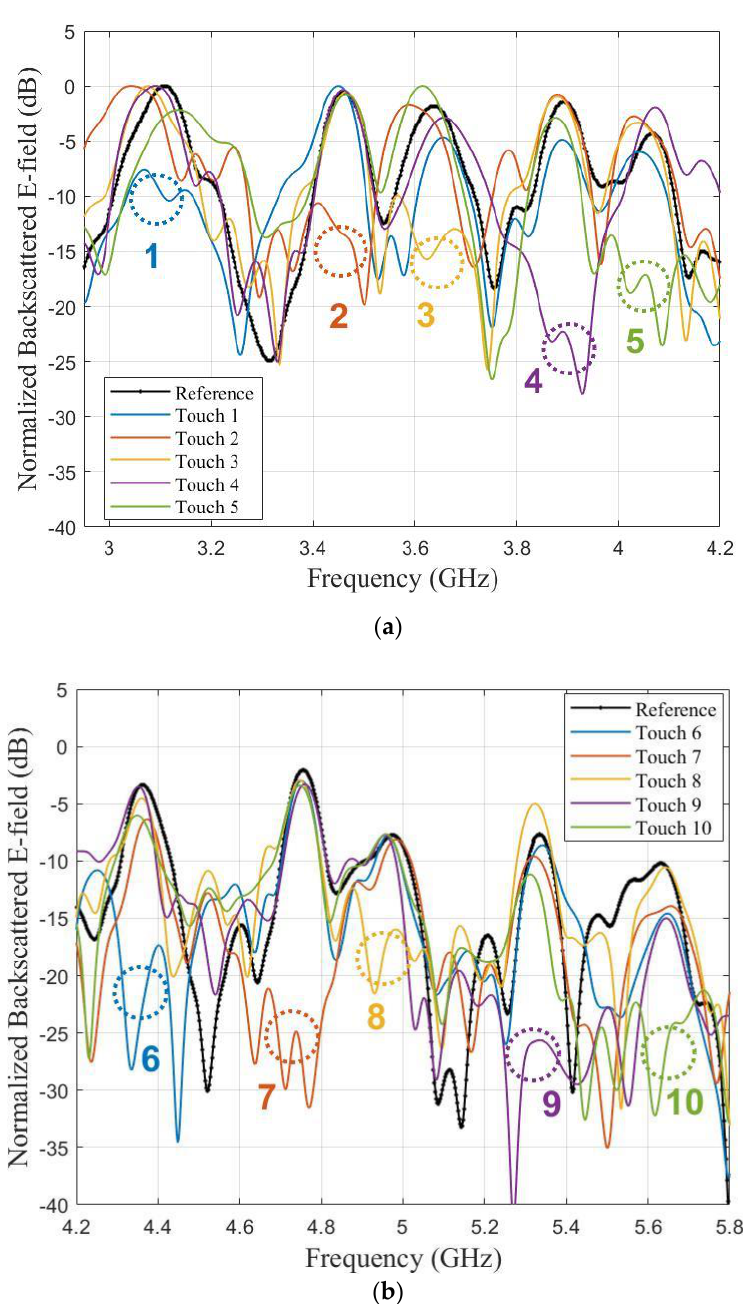
Figure 14. Measured backscattered E-field (in real environment) of the keypad for finger touching: ( a ) Digit 1 to 5; ( b ) Digit 6 to 10.